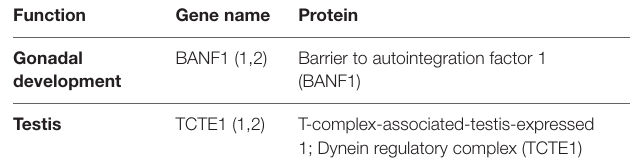
TABLE 2 | Proteins identified in dolphin spermatozoa linked to sperm function